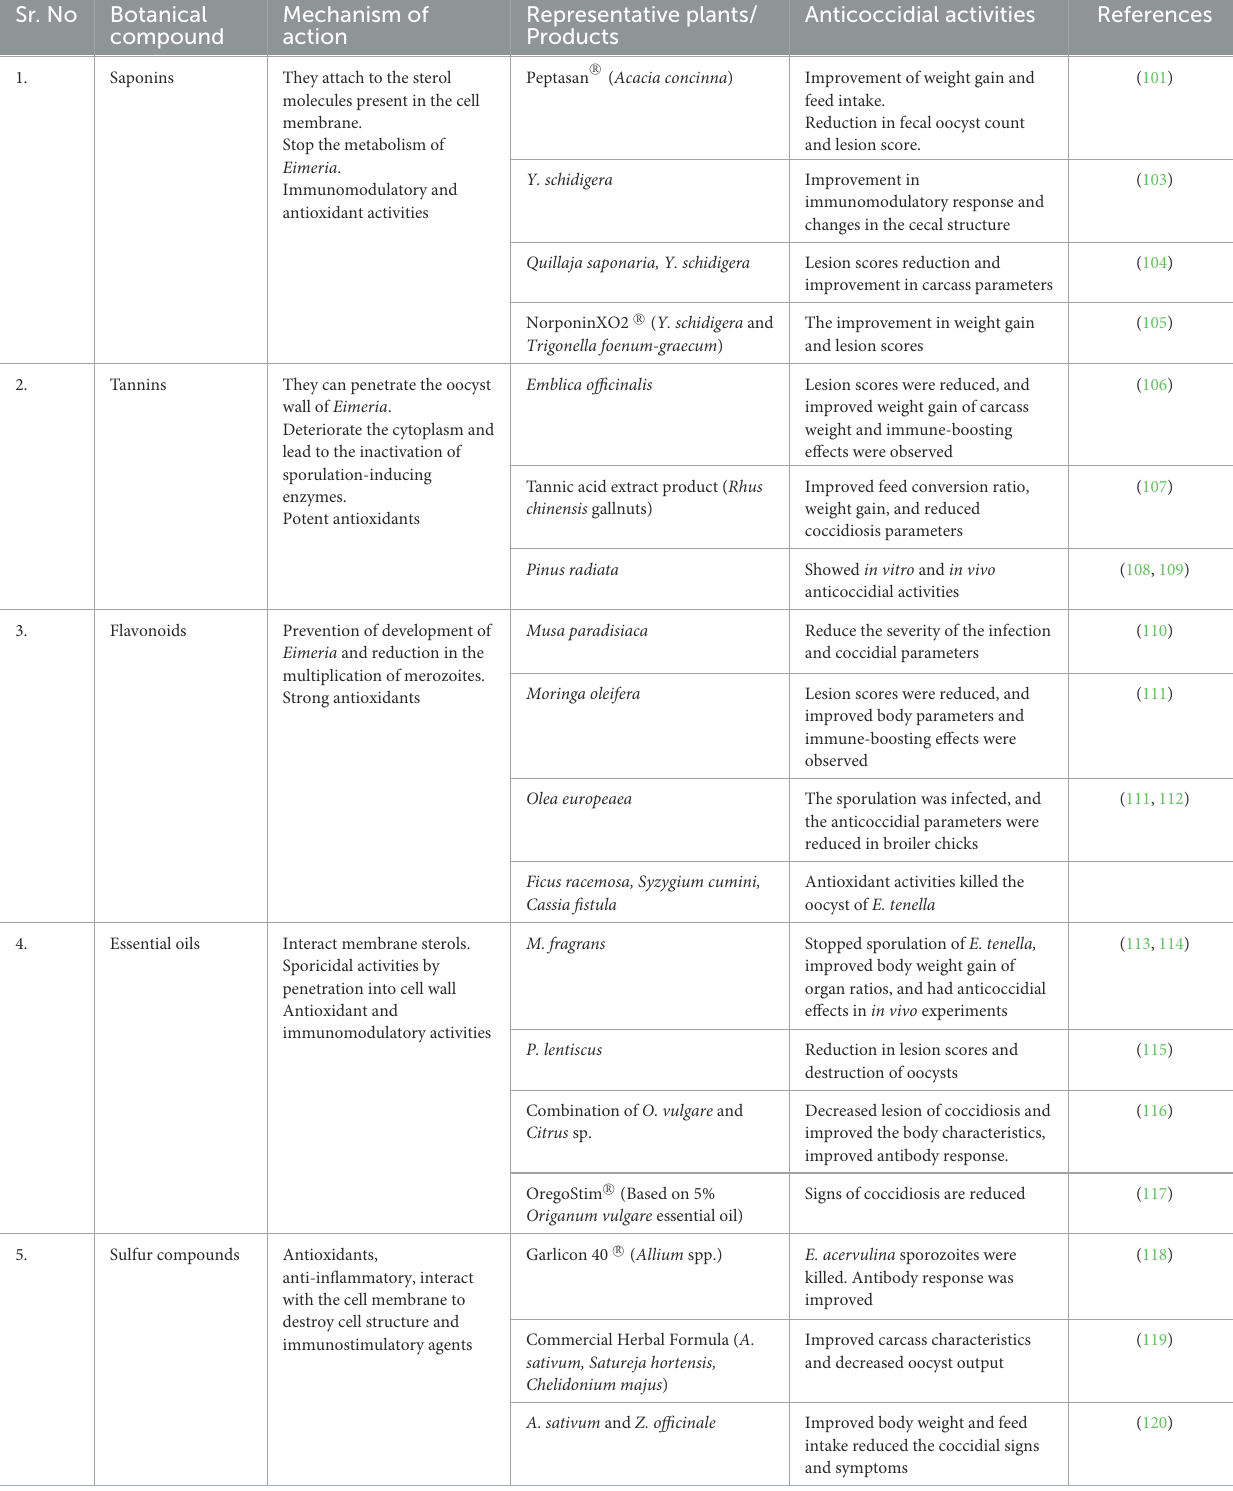
TABLE 2 Botanical compounds, their mechanisms of action, and their use for cecal